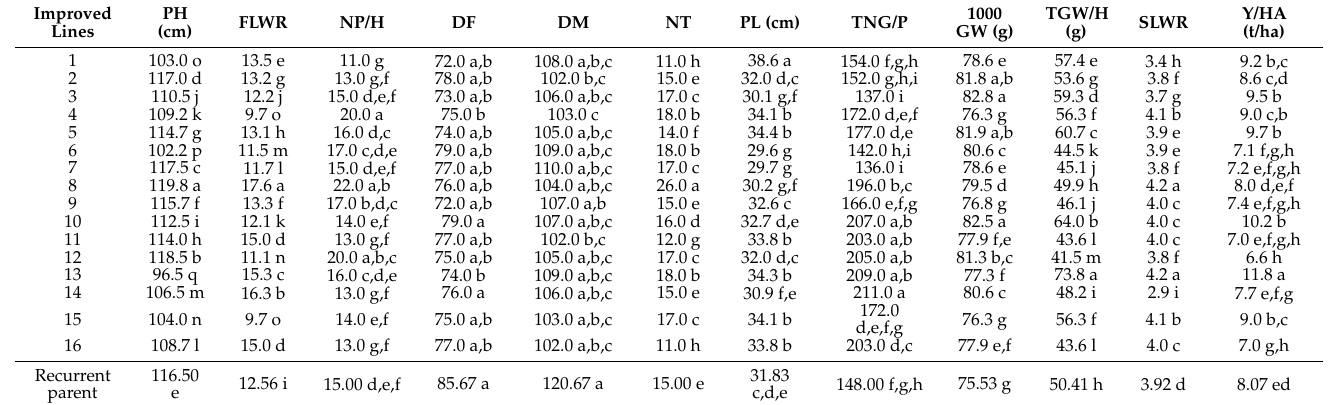
Table 4. Phenotypic selection of improved lines on the basis of their quantitative traits studied on-farm.